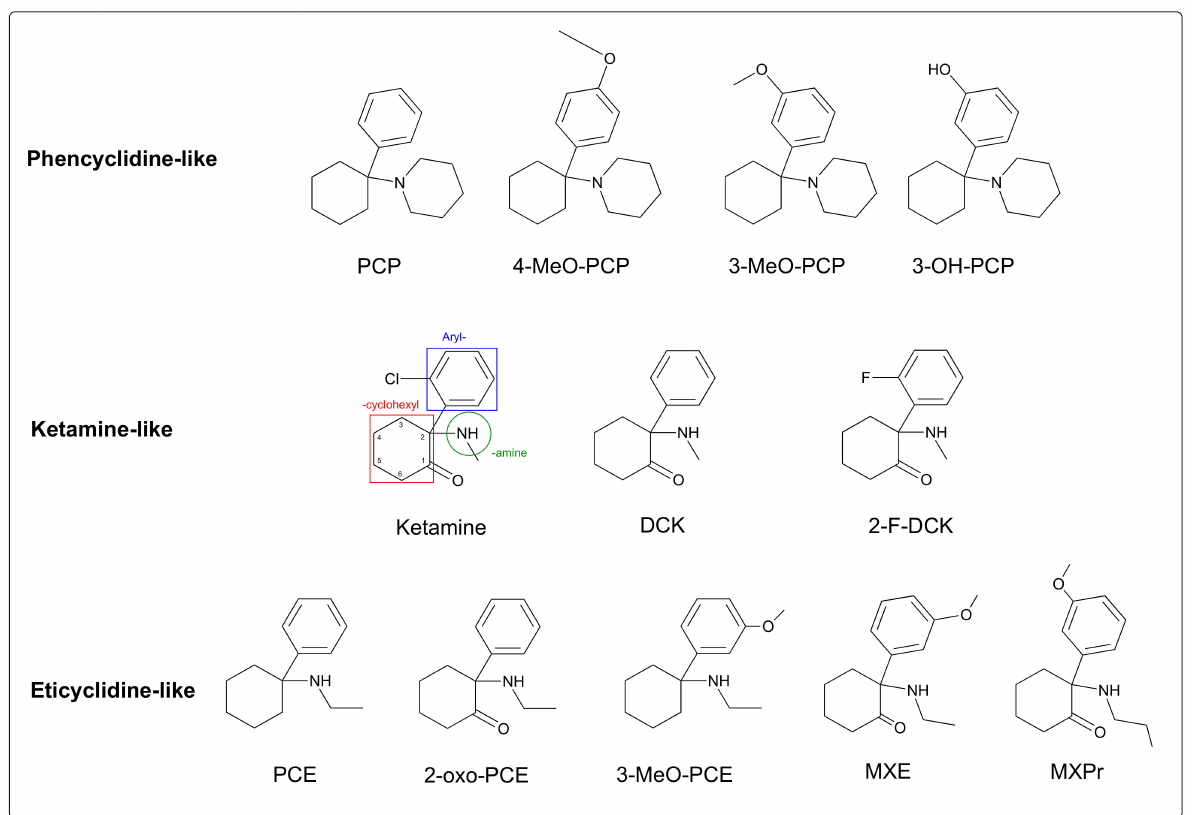
Figure 1. The ACH derivatives most frequently involved in cases of intoxication. PCP: phencyclidine (1-(1-phenylcyclohexyl)piperidine); DCK: deschlorok é tamine (2-(methylamino)-2- phenylcyclohexan-1-one); PCE: eticyclidine (N-ethyl-1-phenylcyclohexan-1-amine); MXE: methox- etamine (2-(ethylamino)-2-(3-methoxyphenyl)cyclohexan-1-one); MXPr: methoxpropamine (2-(3-